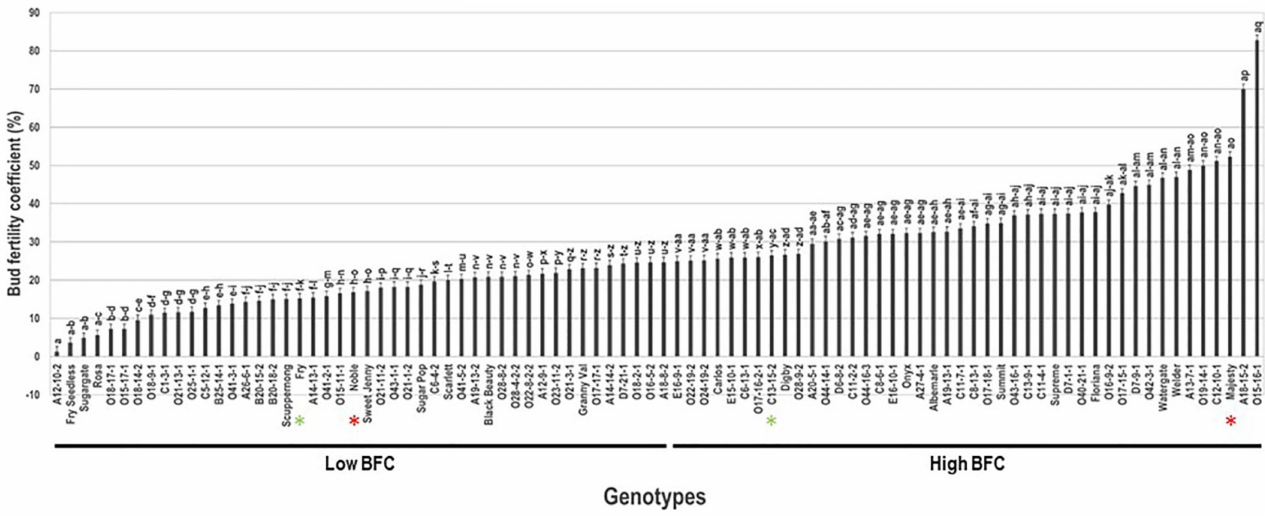
Figure 3. Characterization of bud fertility coefficient (BFC) trait among muscadine population ( n = 90). The bars represent the mean BFC ( ± SD) results from three biological replicates (three vines) over three years ( n = 9). The y-axis refers to the bud fertility coefficient (%). Means within columns for the same letter followed by different letters differ significantly by Tukey’s test ( p < 0.05). Based on median BFC (~24.7%), the population was divided into two equal groups of high and low BFC. Other details are as in Figure